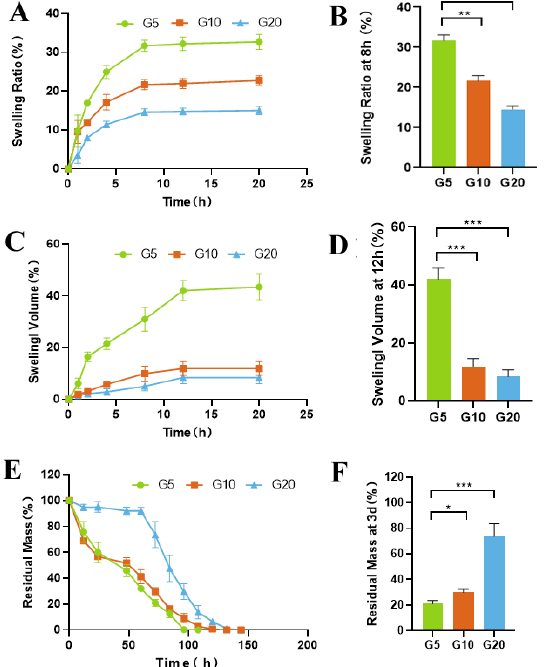
Figure 2. In vitro characterization of the GelMA hydrogels. ( A ) Swelling ratios of the hydrogels at different time points in PBS at 37 °C. ( B ) Swelling ratios of the hydrogels after incubation in PBS at 37 °C for 8 h. ( C ) Volumes of the hydrogels after incubation in PBS at 37 °C for various amounts of time. ( D ) Swelling volume of the hydrogels after incubation in PBS at 37 °C for 12 h. ( E ) Degradation curve of the hydrogels in the presence of collagenase (1 μ g/mL) in PBS at 37 °C. ( F ) Degradation of the hydrogels after incubation in PBS containing 1 μ g/mL collagenase for 3 d. (* p < 0.05, ** p < 0.01, *** p < 0.001; n = 3).